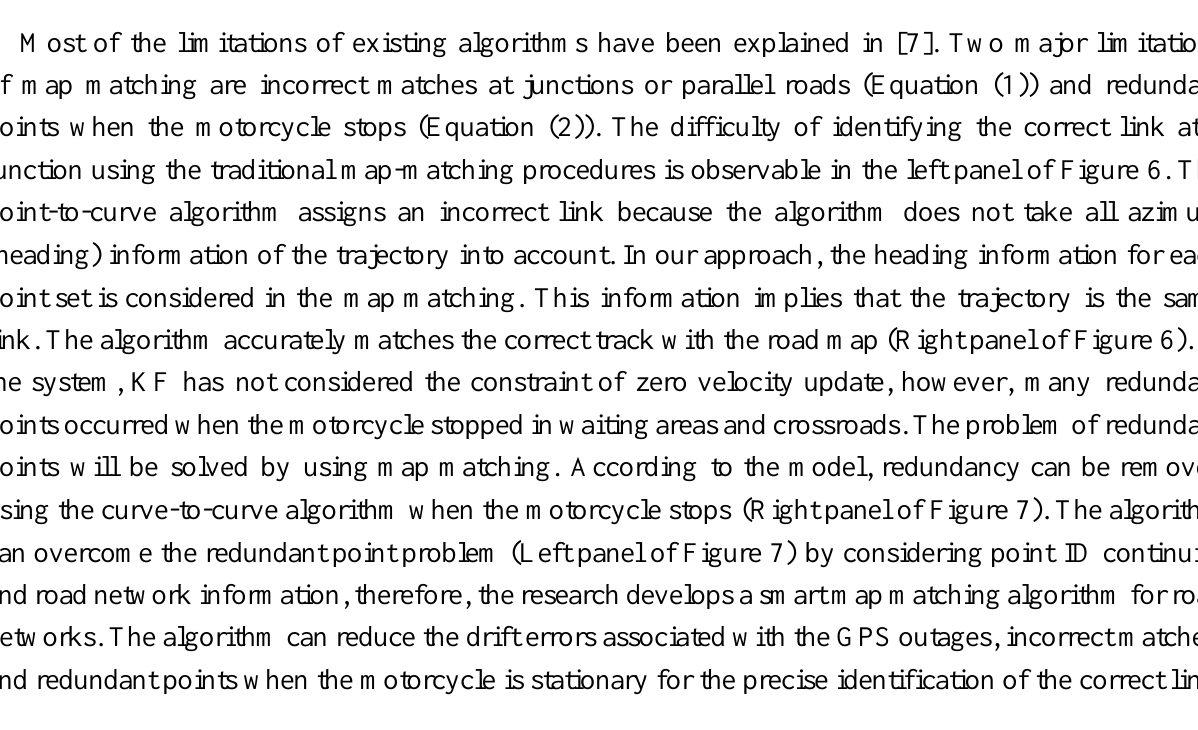
Figure 7. Map matching before ( Left ) and after signal redundancy reduction ( Right